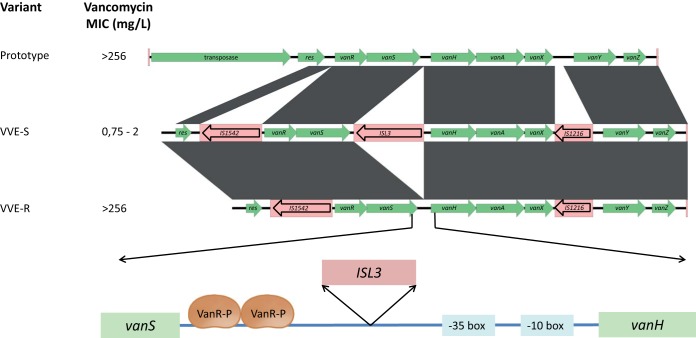
Insertion site of ISL3 illustrated in a scaled alignment of vanA clusters from Norwegian clonal VVE-S and VVE-R to prototype Tn1546 (GenBank accession no. M97297). In the zoomed view, the location of ISL3 between the binding site of the VanR activator (VanR-P) and the vanHAX promoter (−35 and −10 boxes) is indicated.